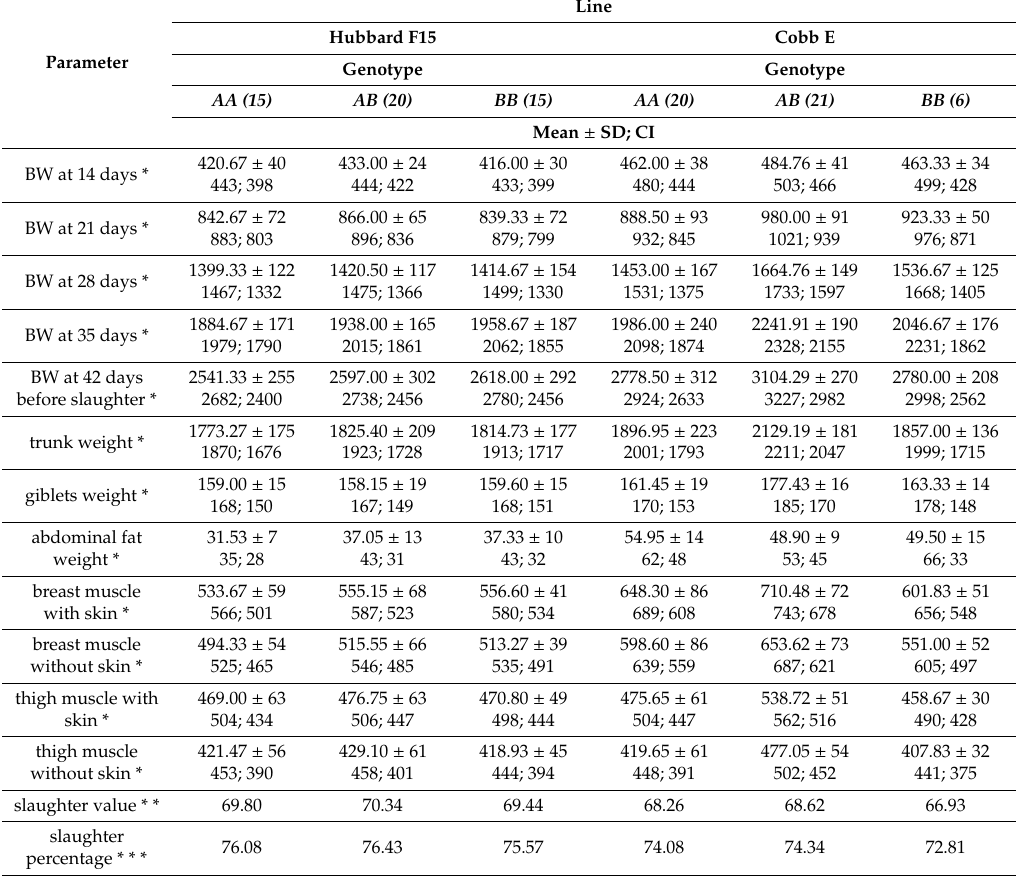
Table 7. The average growth performance and carcass traits in the chicken population (according to TGF β 3